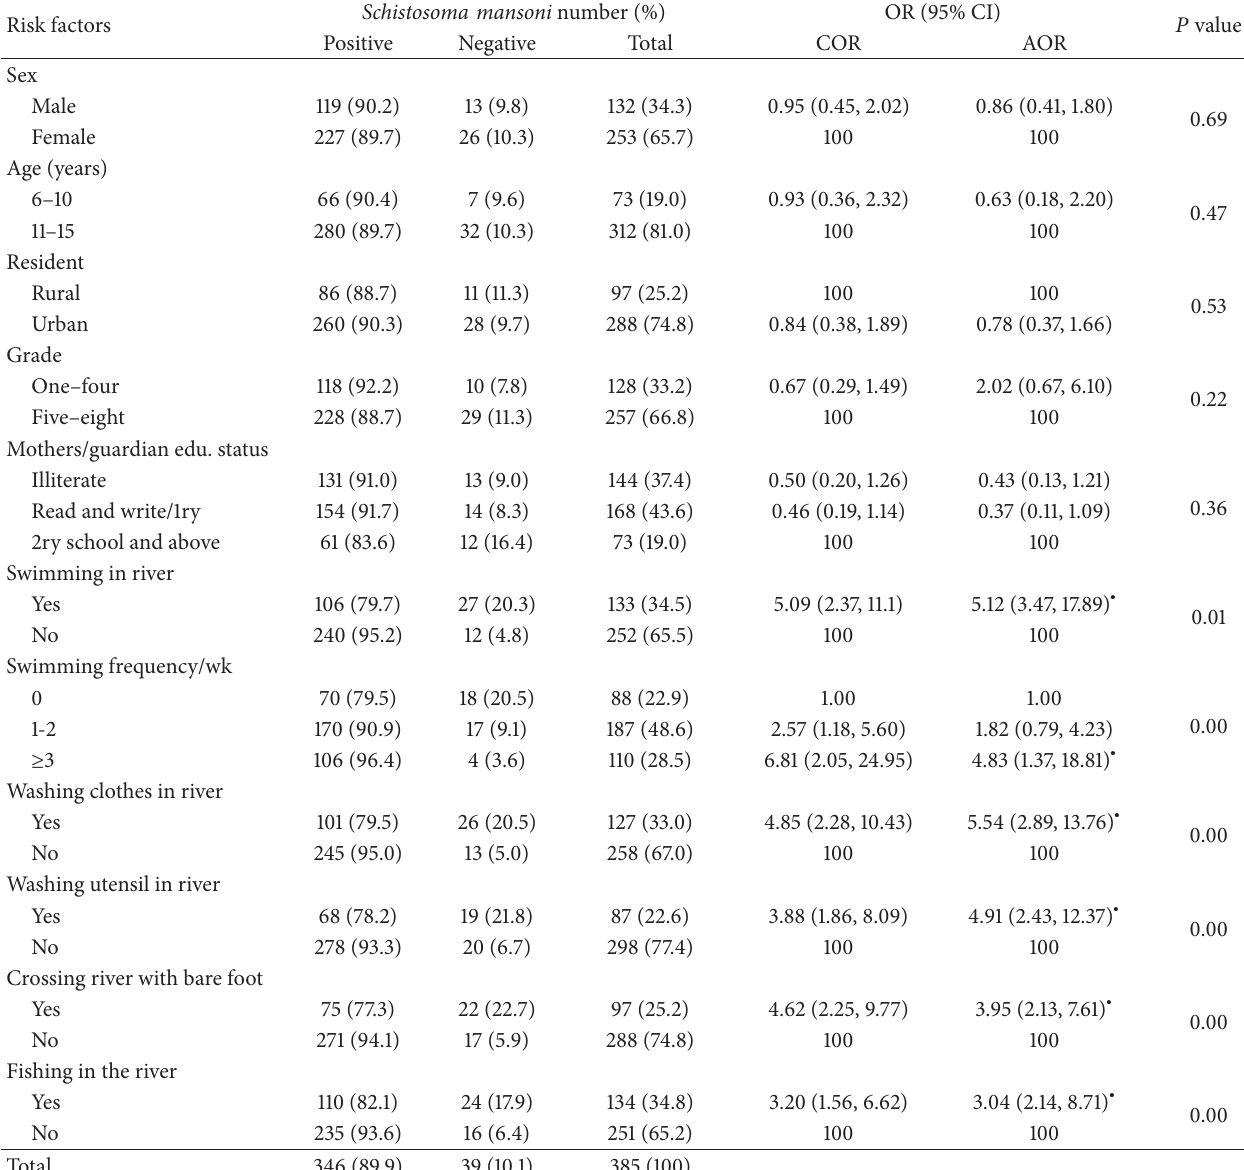
Table 4: Multivariate analysis for factors potentially associated with Schistosoma mansoni infection among Sanja General Elementary School children, northwest Ethiopia,